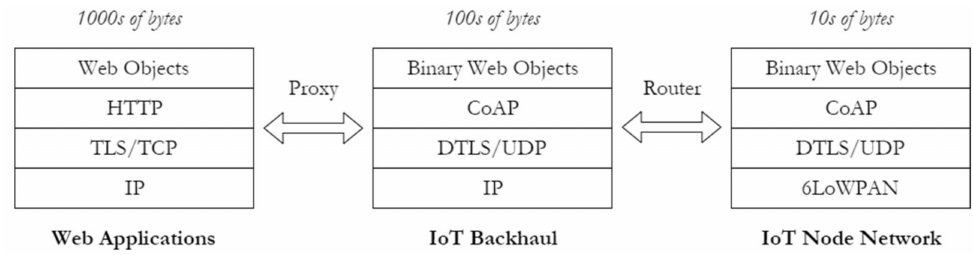
Figure 5. Comparison of web applications and IoT nodes